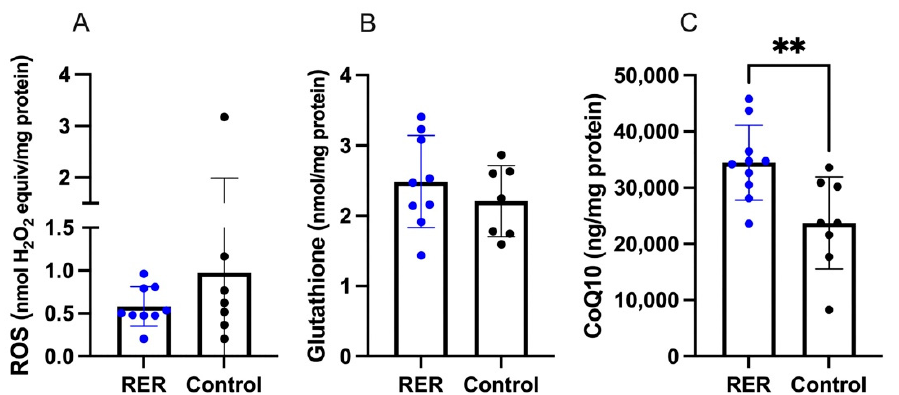
Figure 7. The concentrations of ROS, glutathione and CoenzymeQ 10 in RER-susceptible compared to control horses. ( A ). ROS concentrations ( B ). Glutathione concentrations. ( C ). CoQ 10 concentra- tions. Only CoQ 10 concentrations were significantly higher ( p = 0.0072) in RER-susceptible horses. ** indicates p < 0.01.